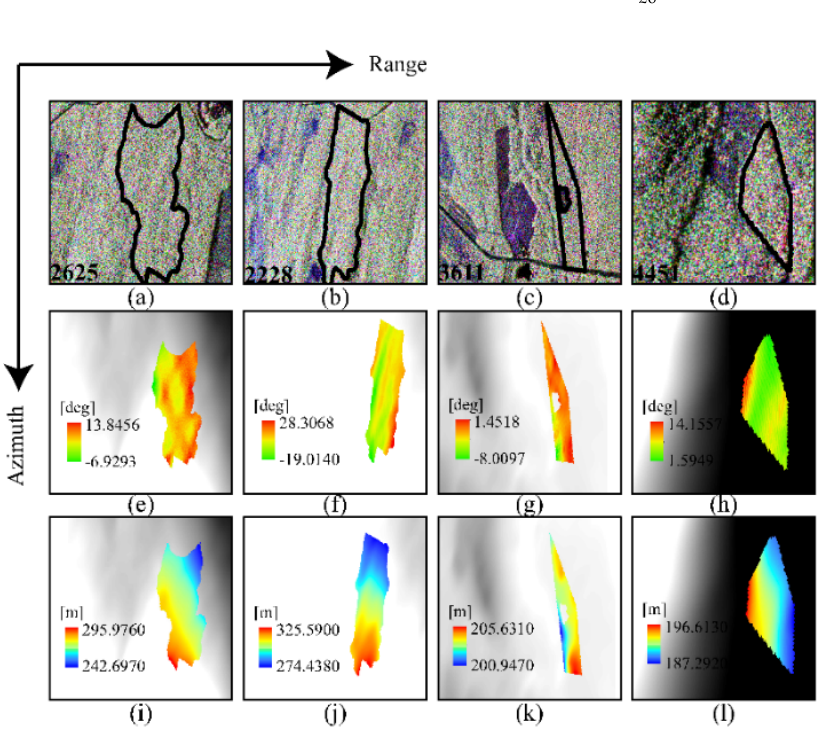
Figure 6. The geometric model of forest scattering is affected by terrain slope. ( a ) The landscape distribution faces the radar sensor when the terrain slope is positive. ( b ) When the terrain slope is negative, the landscape distribution is at the back of the radar sensor. yoz and y o z    are the coor ‐ dinate system under flat terrain and the slope ‐ corrected coordinate system, respectively. B the vertical baseline. S and S are the master image and the slave image, respectively. P is master slave the ground object (e.g., forest),  is the radar incidence angle, is the range slope, h is the slope ‐ corrected forest height under the y o z    coordinate system, and 0 v is the forest height under the yoz coordinate system.